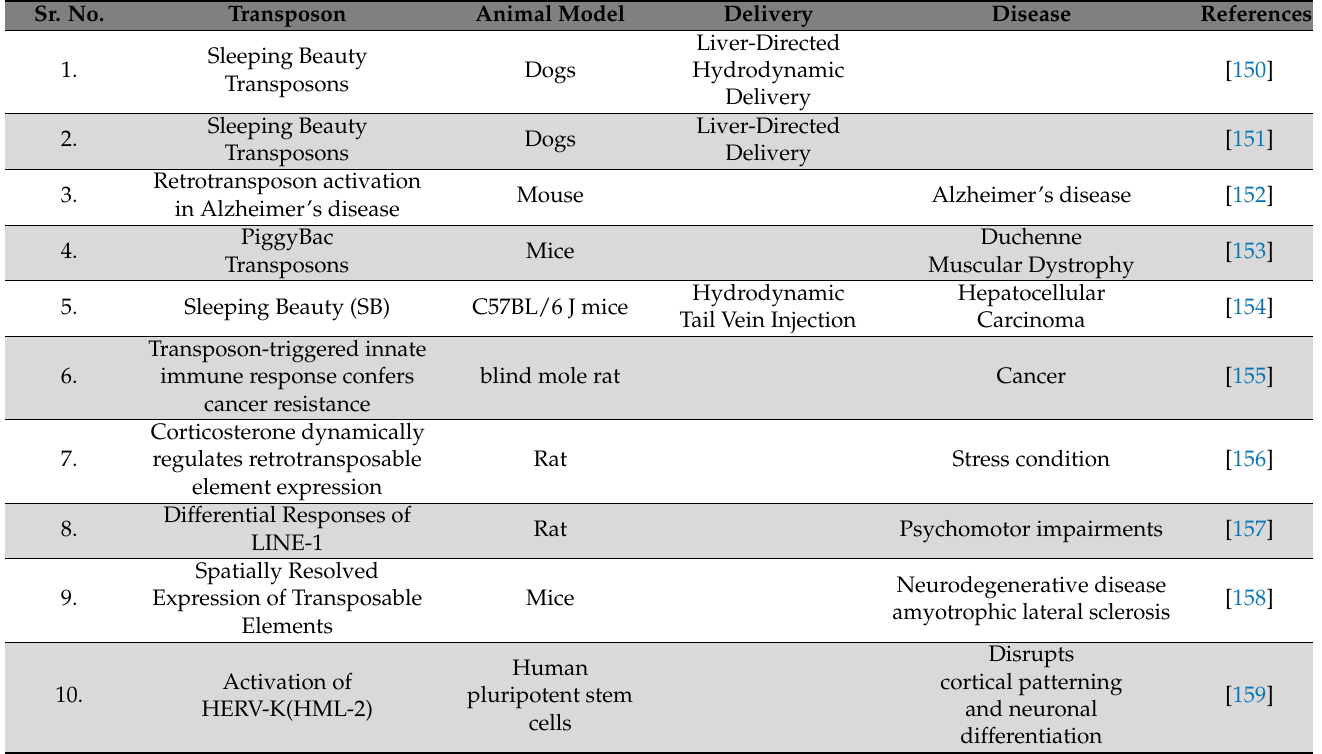
Table 2. Preclinical studies on transposon-based gene